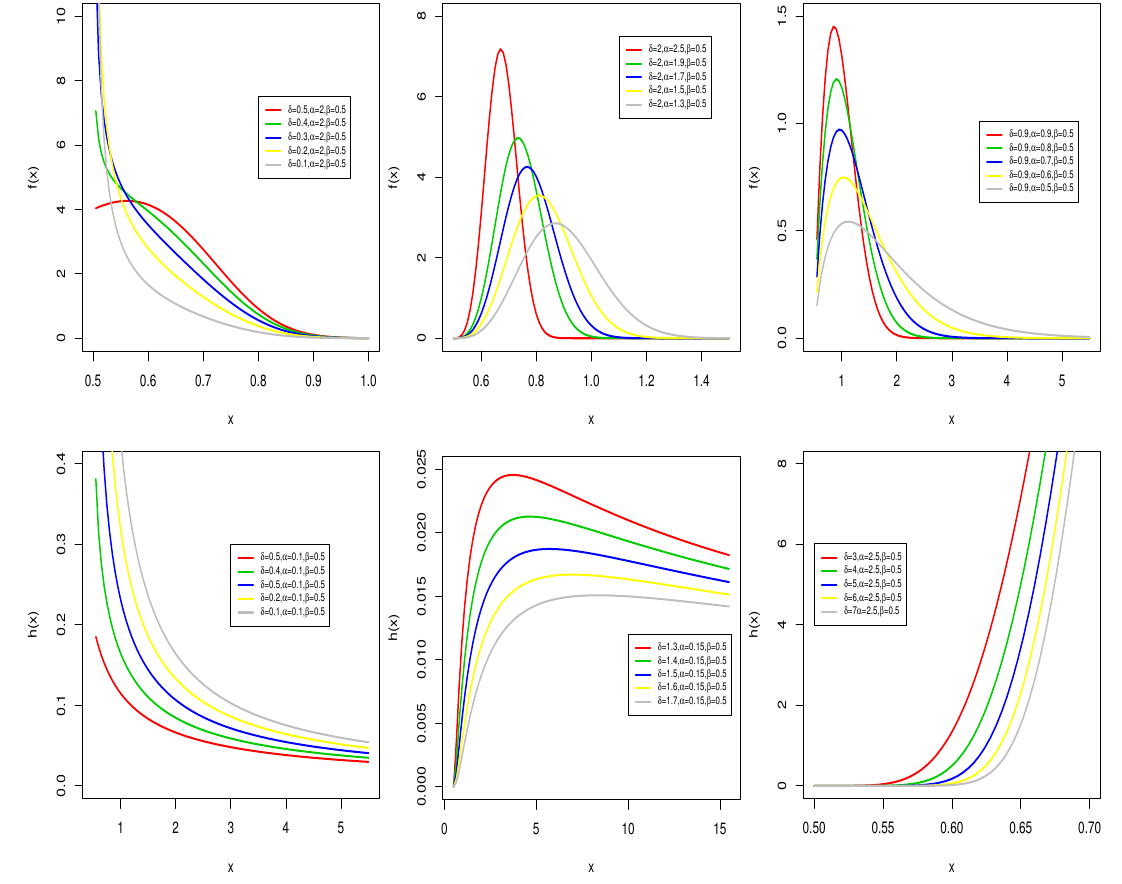
Figure 1. Plots of the Burr XPareto (BXP) pdf ( top ) and plots of the BXP hazard rate function (hrf) ( bottom